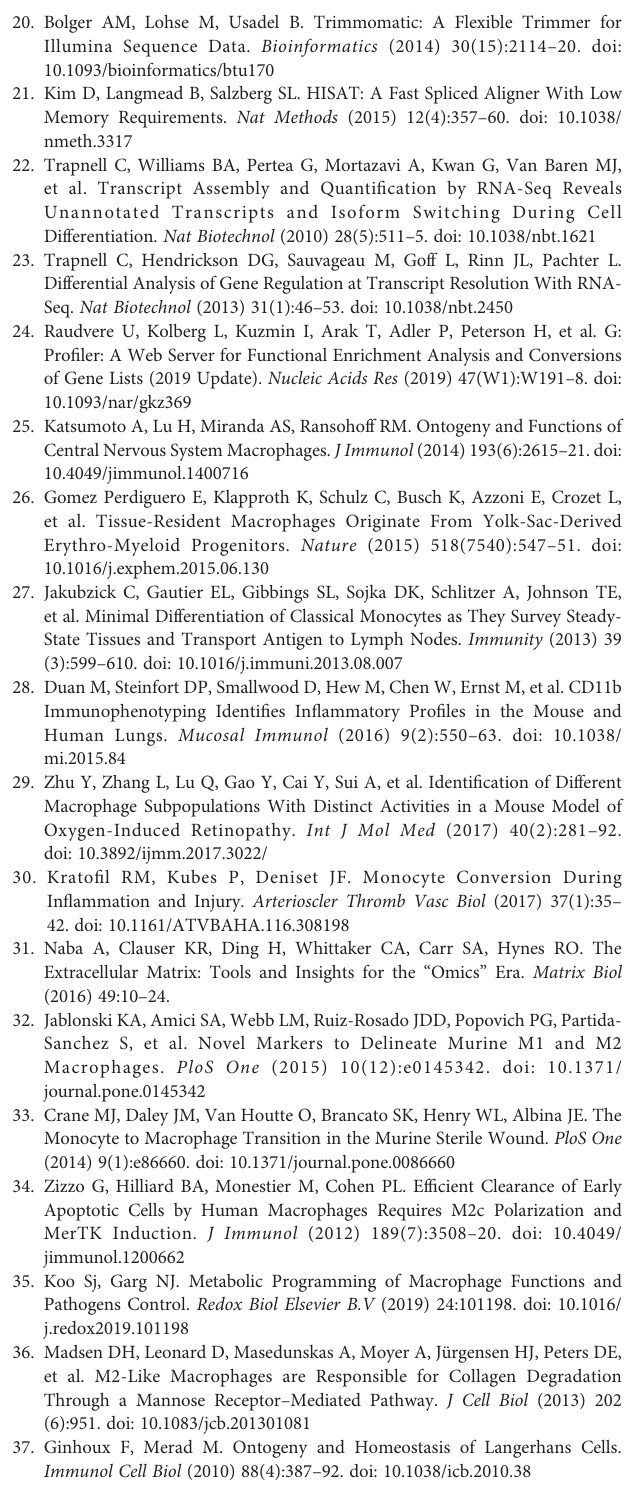
Supplementary Table 2 | List of differentially expressed genes with FDR<0.05 in the epidermis, fi broblasts, and the macrophages of E18.5 epidermal Itg b 1 KO skin.